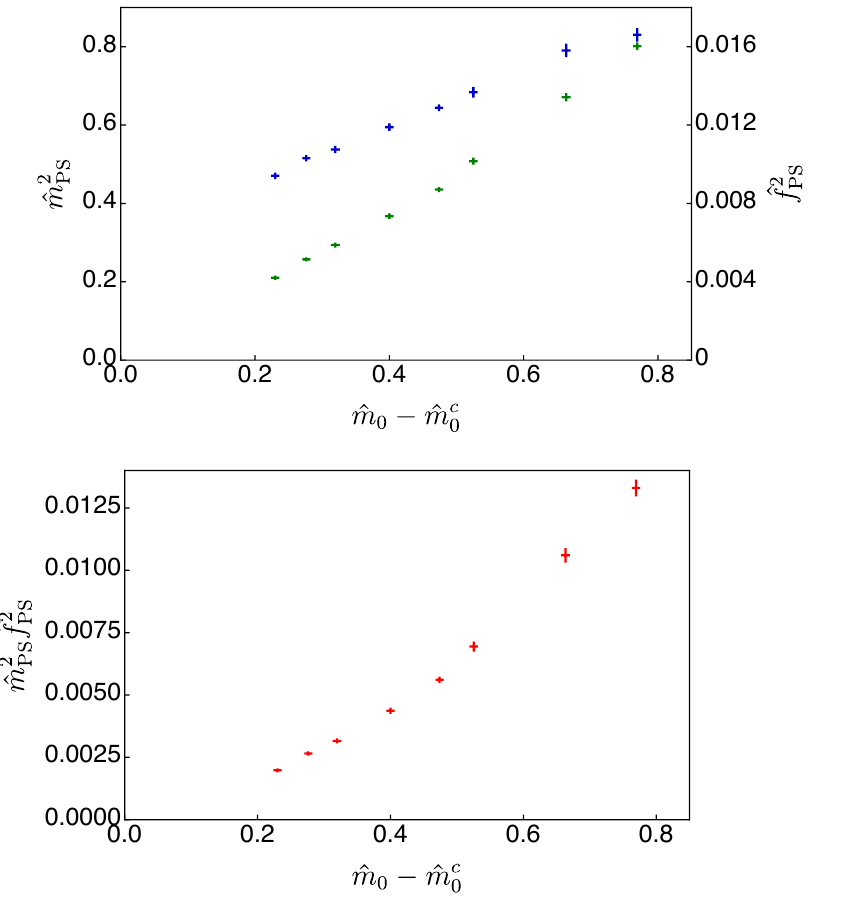
Figure 6. Top panel: pseudoscalar masses squared ^ m PS and decay constants squared ^ f 2 function of the subtracted bare fermion mass. Green and blue symbols stand for ^ m 2 respectively. Bottom panel: left-hand side of the GMOR relation, as a function of the subtracted fermion mass. All points computed with (cid:12) = 7 : 2. The uncertainty on the horizontal axis descends form the determination of ^ m c 0